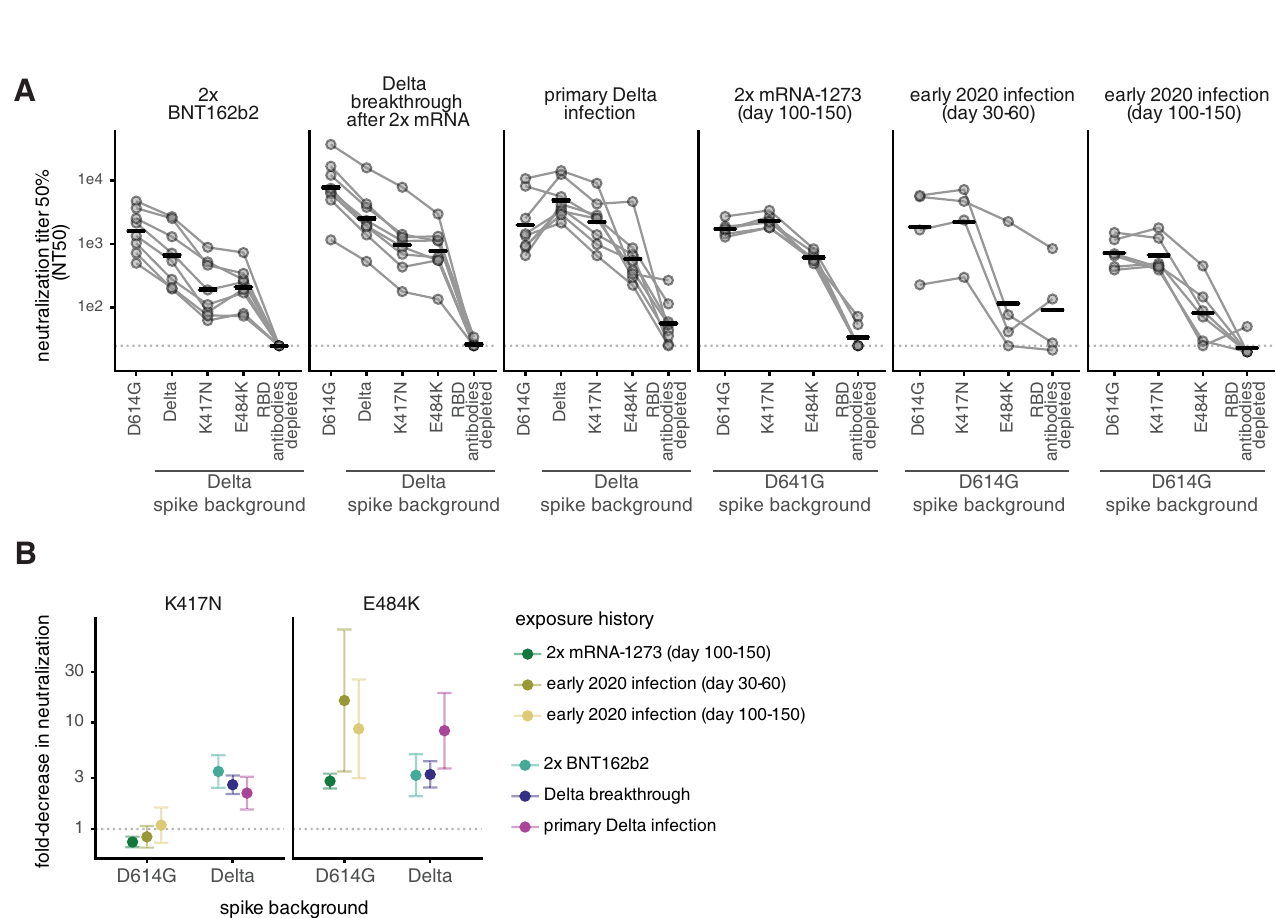
Fig 5. Delta breakthrough infection after 2x mRNA vaccination elicits an antibody response focused on the class 1 and 2 epitopes. (A) Complete maps of mutations that reduce binding of plasma antibodies to the Delta RBD from individuals convalescent of Delta breakthrough infection. The same sites as in Fig 3B are shown in the logo plots and highlighted in pink in the line plots. Logo plots for both cohorts are shown side-by-side in S6 Fig . (B) Site-total antibody escape averaged across each group of plasmas for primary Delta convalescent plasmas, Delta-breakthrough convalescent plasmas, and previously published mRNA-1273-vaccinated sera [29], with key epitope regions highlighted (key in panel D). (C) Site-total antibody escape averaged across each group mapped to the RBD surface, with red indicating the site with the most antibody escape and white indicating sites with no escape. The Delta primary infection and Delta breakthrough plasmas were mapped against the Delta RBD libraries, and the mRNA-1273 sera were mapped against the Wuhan-Hu-1 RBD libraries. Site labels are colored by epitope. (D) Multidimensional scaling projection with the distance between points representing the dissimilarity between antibody-escape maps, comparing primary Delta infections, Delta breakthrough after 2x mRNA vaccination convalescent plasmas, and mRNA- 1273-vaccinated sera with monoclonal antibody escape maps of the 4 classes used as anchors, first reported in [22,24,42–44]. The antibody-escape maps for mRNA-1273 vaccine-elicited sera were first reported in [29], and primary Delta and Delta breakthrough infections are new to this study. The primary Delta infection escape maps are replicated from Fig 4 . Interactive versions of logo plots and structural visualizations are at https://jbloomlab.github.io/SARS-CoV- 2-RBD_Delta/. The complete antibody-escape scores are in S3 Data and online at https://github.com/jbloomlab/SARS-CoV-2-RBD_Delta/blob/main/ results/supp_data/aggregate_raw_data.csv.